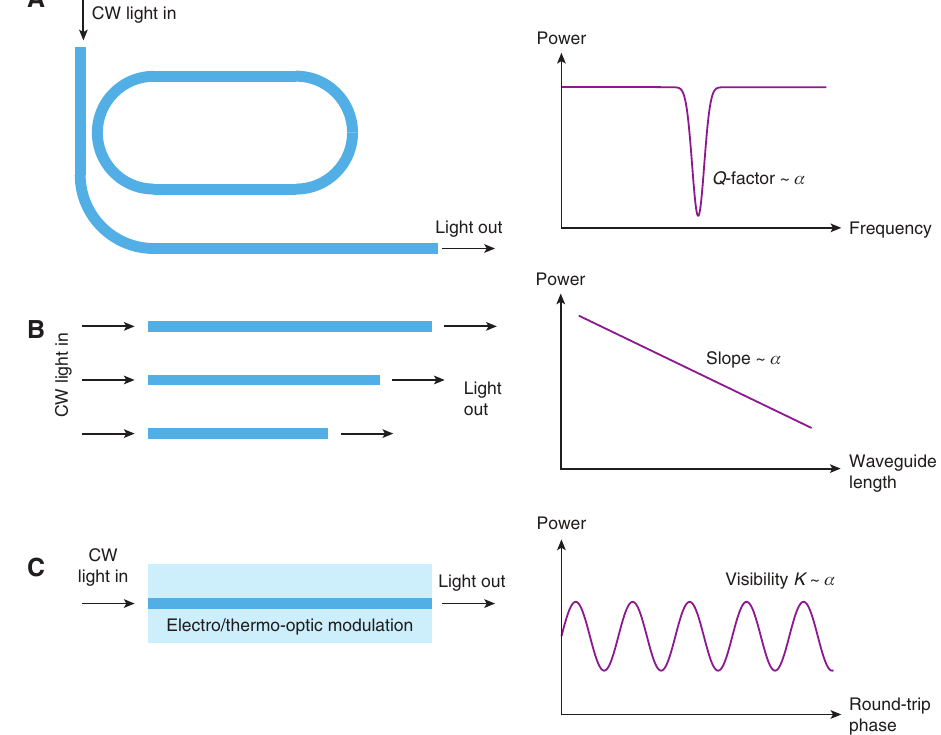
Figure 8: Schematic diagrams of measuring waveguide loss by different methods. The figure above describes the principle and ideal measurement results for (A) microring method, (B) cut-back method, and (C) interferometric method,